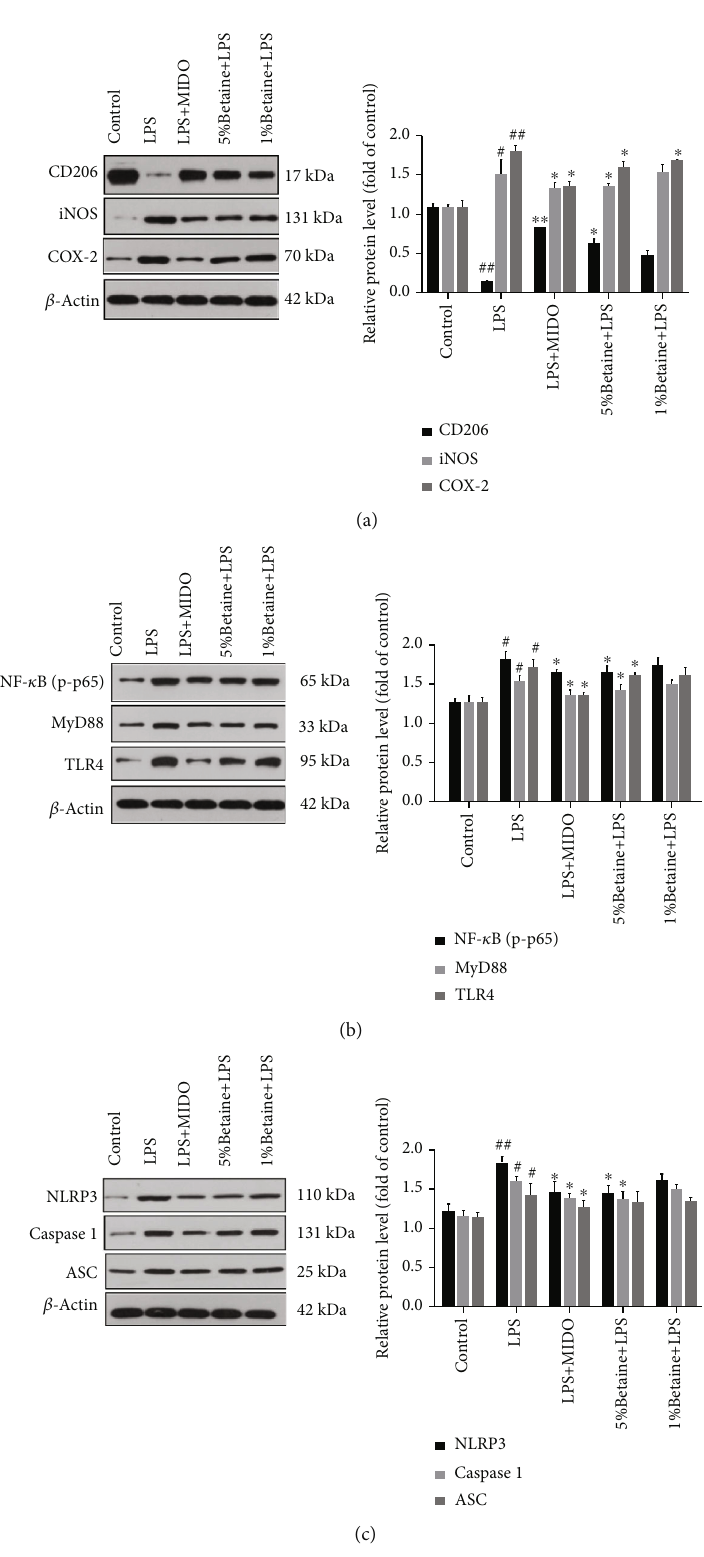
Figure 8: The e ff ects of betaine on LPS-induced NLRP3/TLR4/NF- κ B signal transduction in mice. Western blot analysis of (a) CD206/ iNOS/COX-2 protein levels, (b) P-NF- κ B/MyD88/TLR4 protein levels, and (c) NLRP3, caspase-1, and ASC protein levels; data were presented as mean ± SEM ; # P < 0 : 05 and ## P < 0 : 01 compared to the normal control group; ∗ P < 0 : 05 and ∗∗ P < 0 : 01 compared to the model group, n = 4